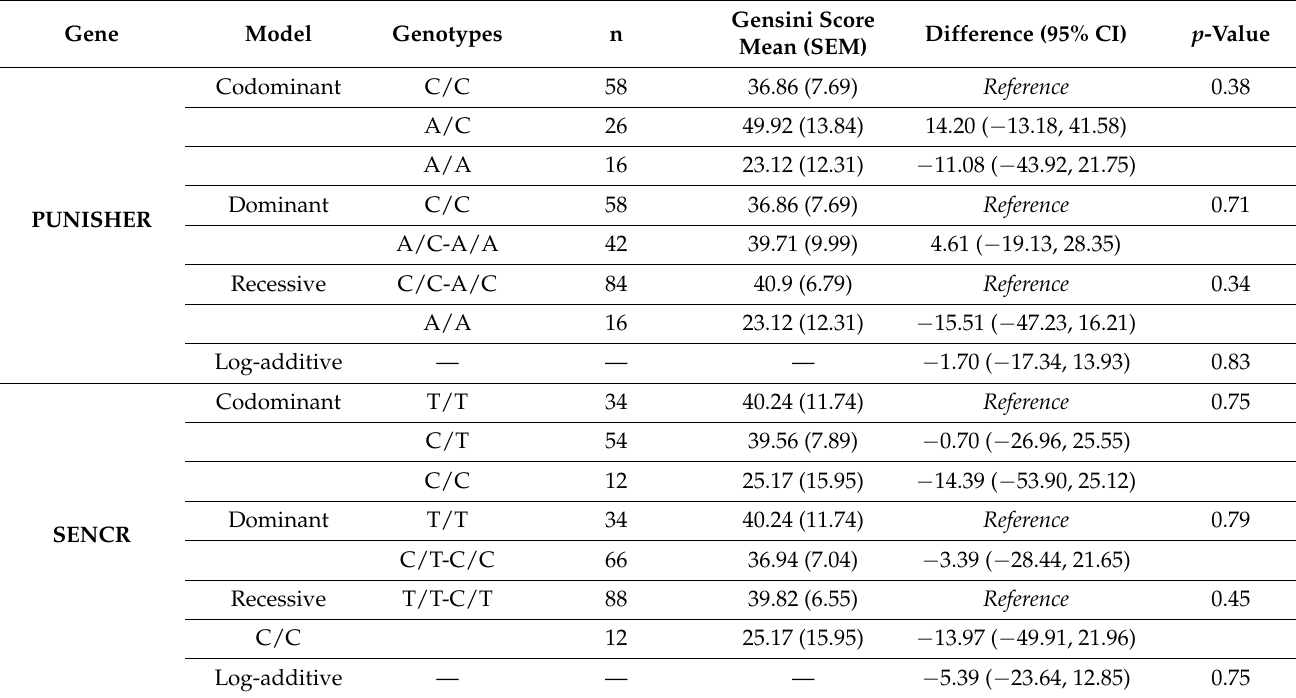
Table 5. Association of lncRNA variants with Gensini score during